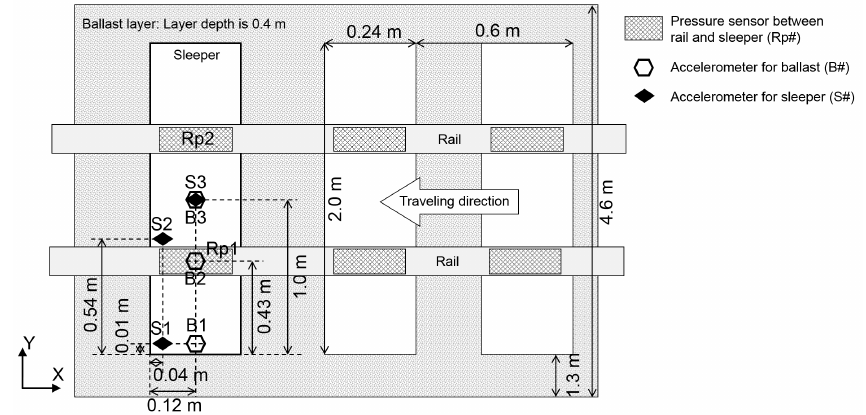
Figure 6. Position diagram for measurements of pressure between the rail and sleeper and accelerations of the ballast particle and sleeper. Accelerometers for the ballast particle were installed in the ballast layer below 10 cm from the bottom of sleeper. Accelerometers for the sleeper were installed on top of the